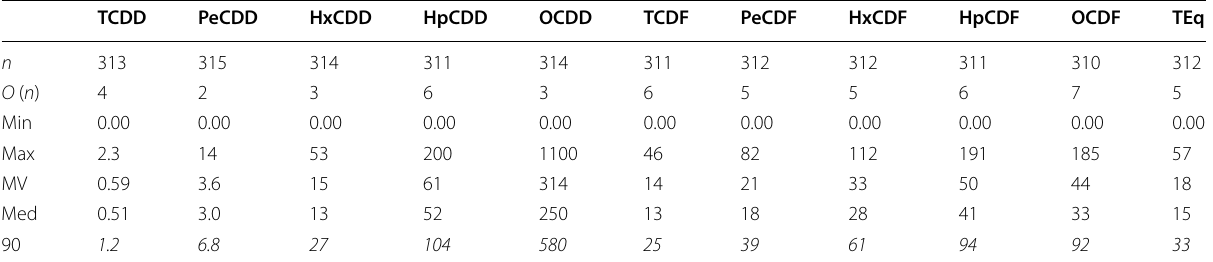
Table 1 Descriptive statistical results of PCDD/F-homologues [ng kg − 1 DM] in organic layers of Bavarian forest soils